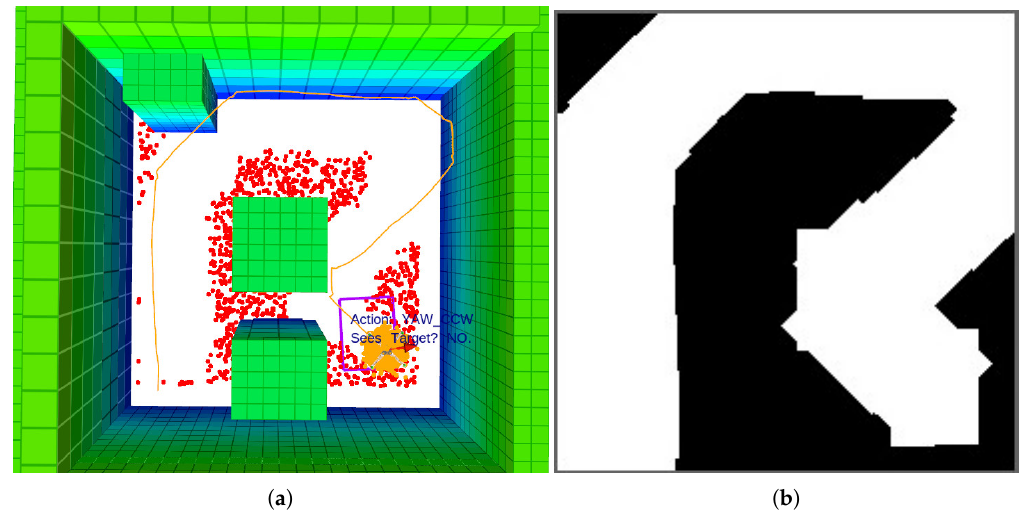
Figure 5. Example of a recorded trajectory. ( a ) Traversed path by the UAV. The figure is composed by: The path of the UAV (orange splines); the environment obstacles (green blocks); the UAV position belief (orange point-cloud); the possible victim location coordinates (red point-cloud); and the camera’s Field of View (FOV) (purple rectangle). ( b ) Traced footprint using the camera’s Field of View (FOV). Future actions that place the UAV inside the white areas trigger r fov